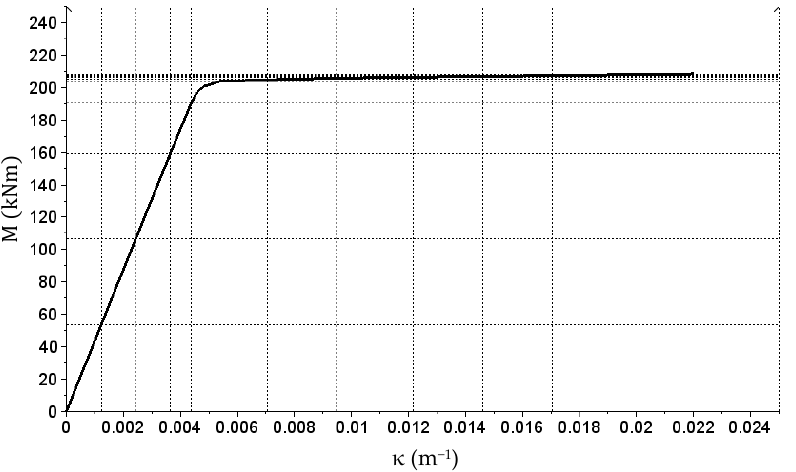
(cid:2869)(cid:2926) matrix (reinforcement of 3 Ø20). matrix (reinforcement of 3 Ø20). Figure 18. The M(κ) relation graph corresponding to the E 1